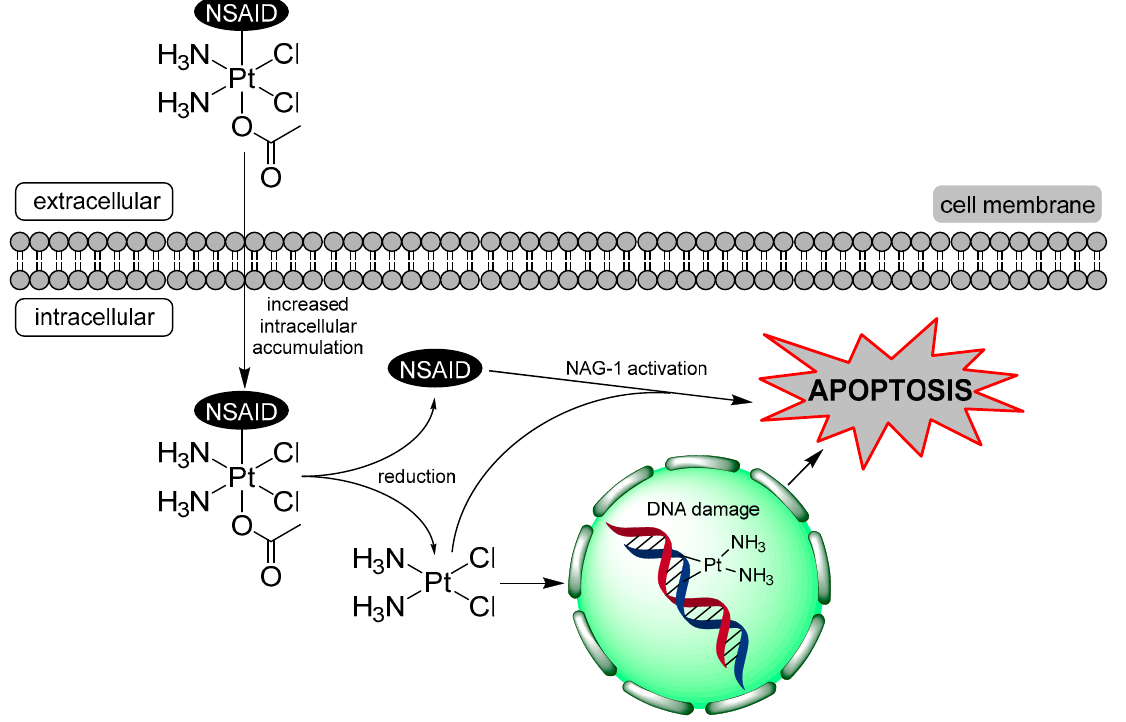
Figure 8. Proposed mechanism of action of the Pt(IV)-NSAID complexes.